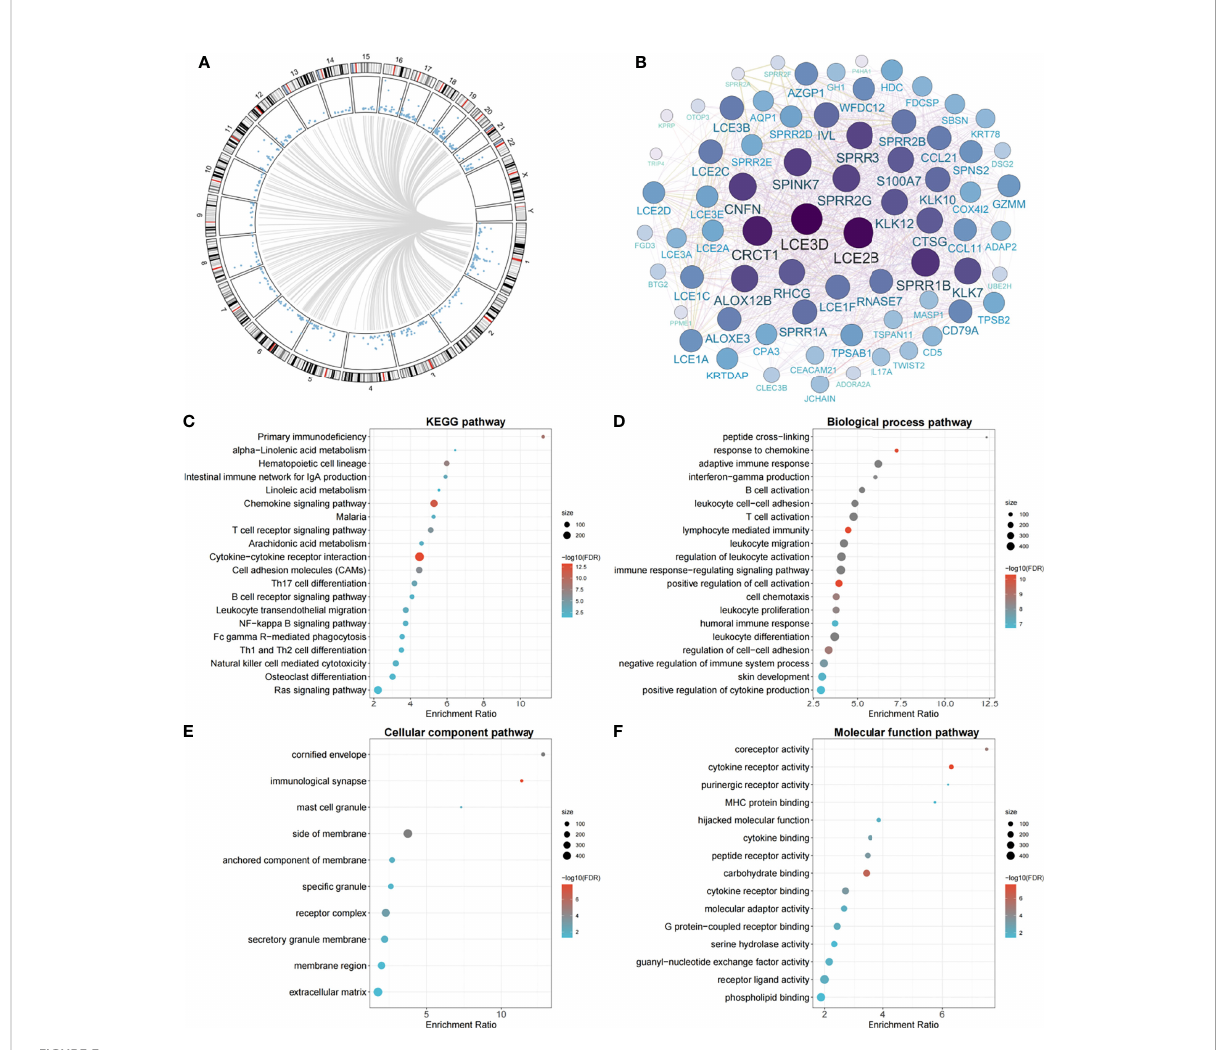
FIGURE 3 Circos plot of genome-wide methylation – transcription analysis, gene network of prognostic genes trans -regulated by cg11676291 MORN1 , and signi fi cant pathways of gene enrichment pathway analysis. (A) Circos plot of genes trans -regulated by cg11676291 MORN1 in the TCGA cohort. Blue points ordered by genomic position represent P values derived from linear regression between gene expression and cg11676291 MORN1 . Grey lines represent signi fi cant correlations with FDR- q ≤ 0.05. (B) The gene network plot of 50 genes trans -regulated by cg11676291 MORN1 and associated with OSCC overall survival. The size represents the connectivity degree of each node. (C) The top 20 signi fi cant KEGG pathways. (D) The top 20 signi fi cant biological process pathways. (E) The top 10 signi fi cant cellular component pathways. (F) The top 15 signi fi cant molecular function